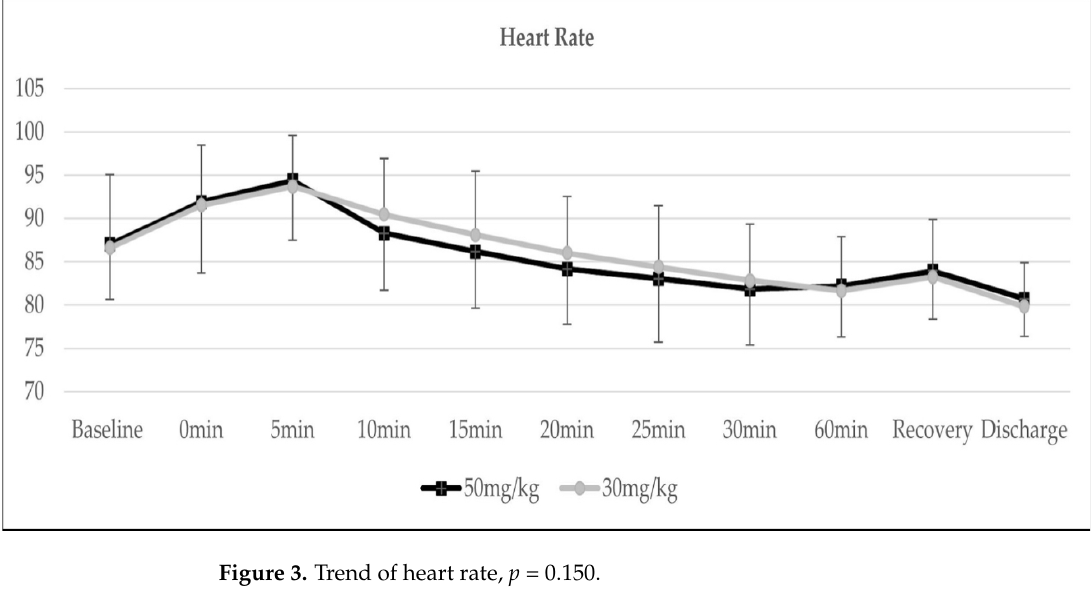
Figure 2. Trend of oxygen saturation, p = 0.040; * p < 0.05 (intragroup comparison with baseline MAP).